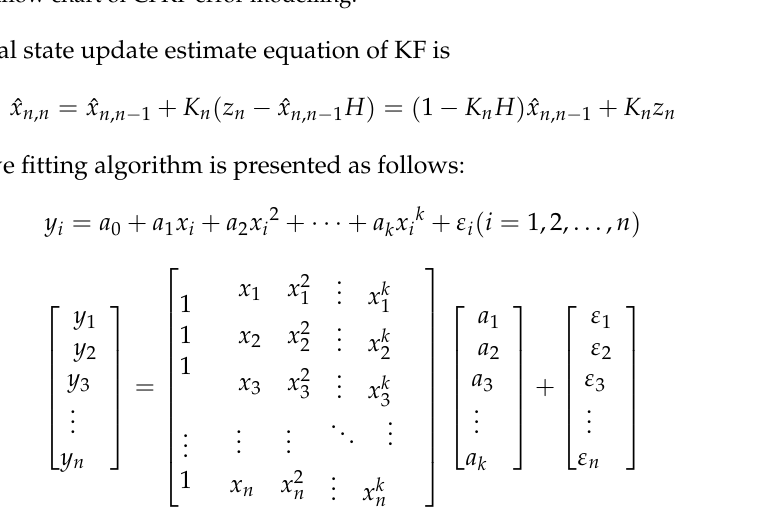
Figure 1. Workflow chart of CFKF error modelling.